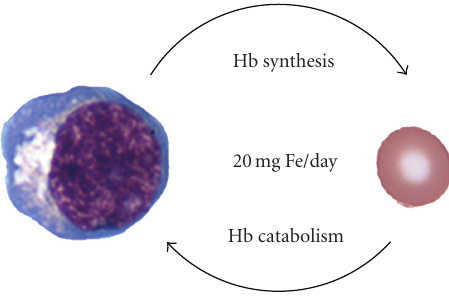
Figure 1: The hemoglobin iron